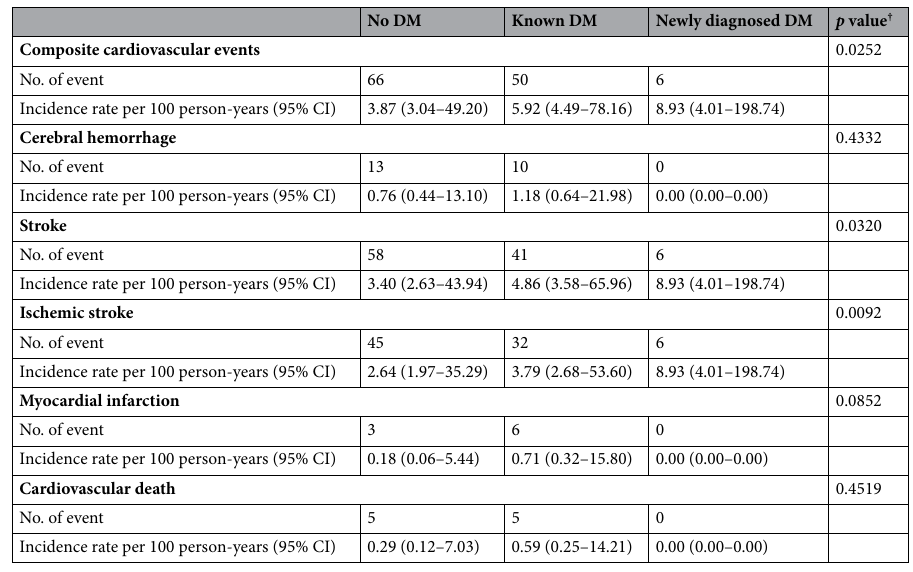
Table 2. Comparison of incidence rate among diabetes status. DM diabetes mellitus, CI confidence interval. † p-value by log rank